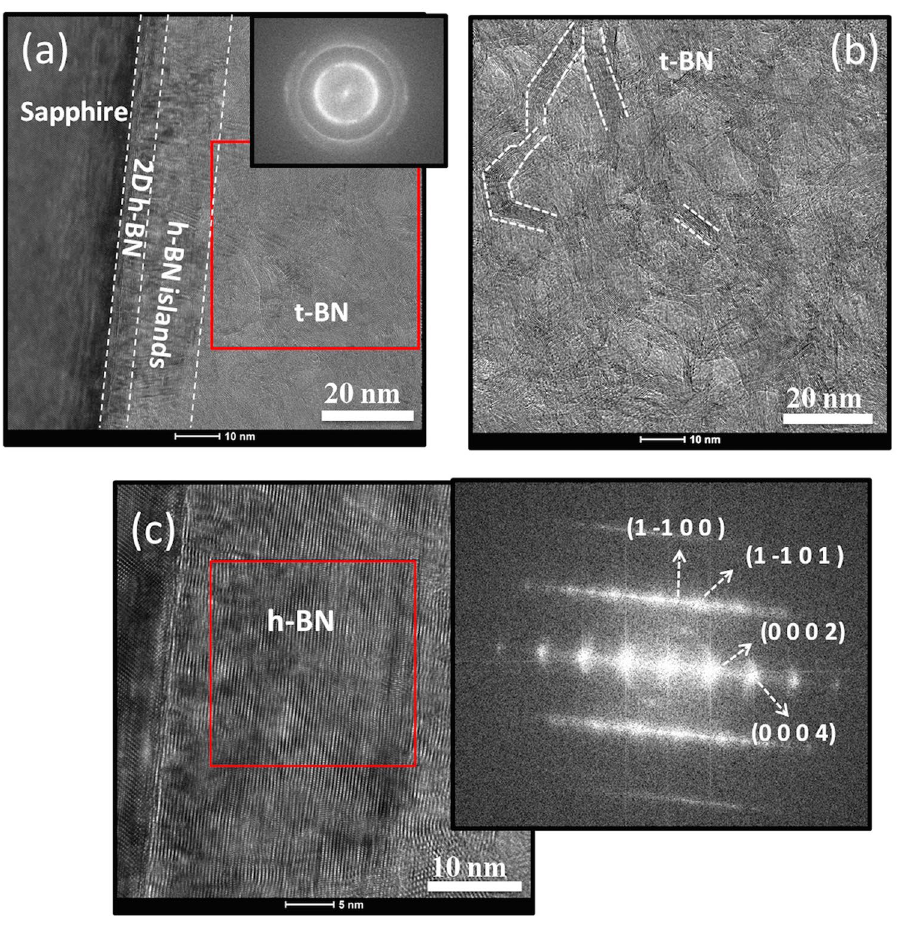
Figure 2. ( a ) Cross-section high-resolution TEM (HRTEM) image of 1 µ m-thick BN grown on sapphire substrate which was taken along zone axis of < 1 1–2 0 > . Inset is the Fourier transform (FT) pattern for the